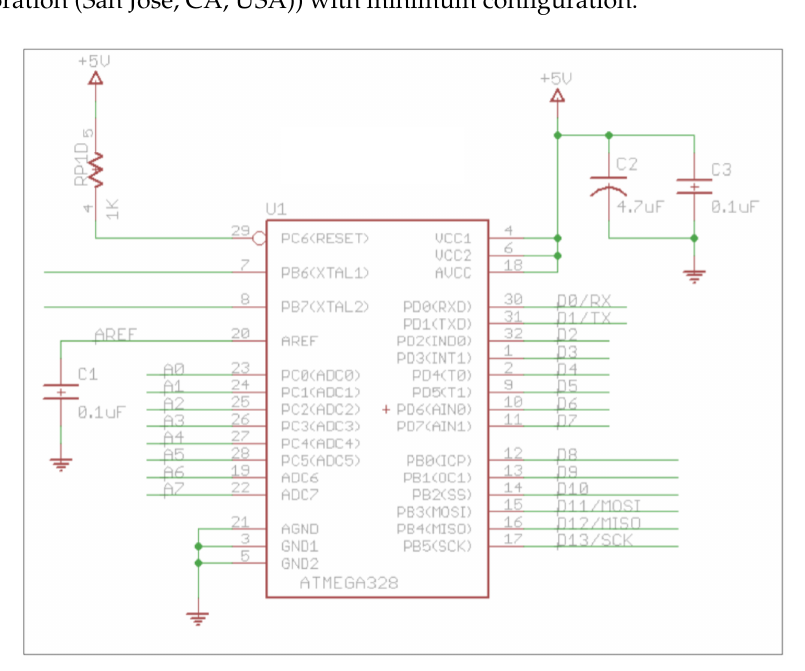
Figure 3. Microcontroller schematic.